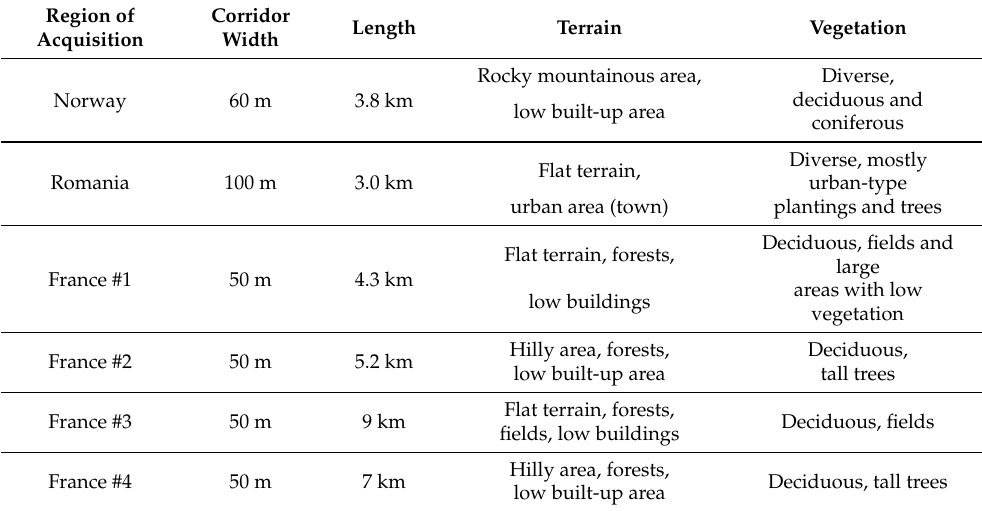
Table 1. Summary of training data and their